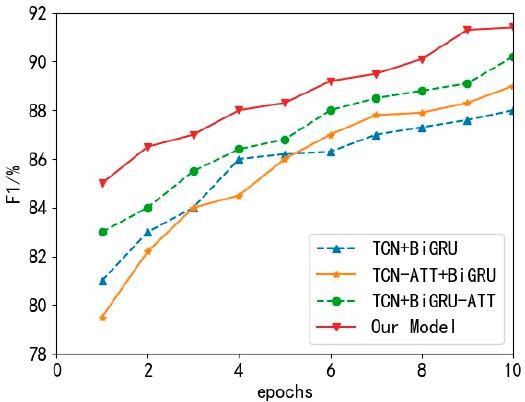
Figure 5. F1 value change of the different attention mechanisms.